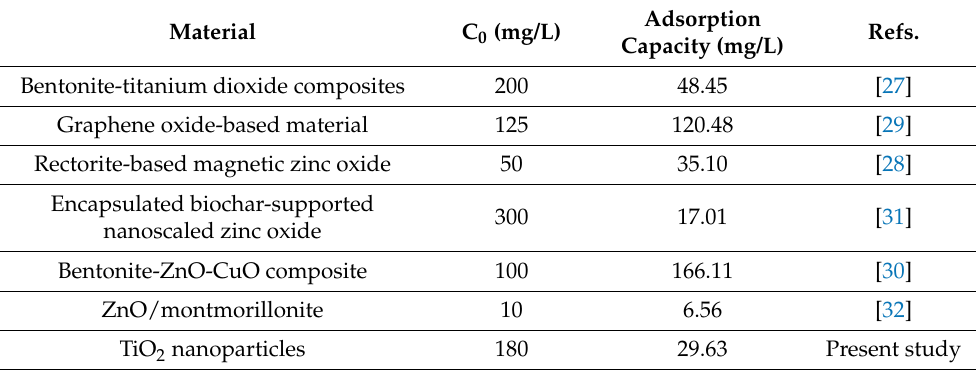
Table 3. Comparison of MB adsorption onto TiO 2 nanoparticles and other